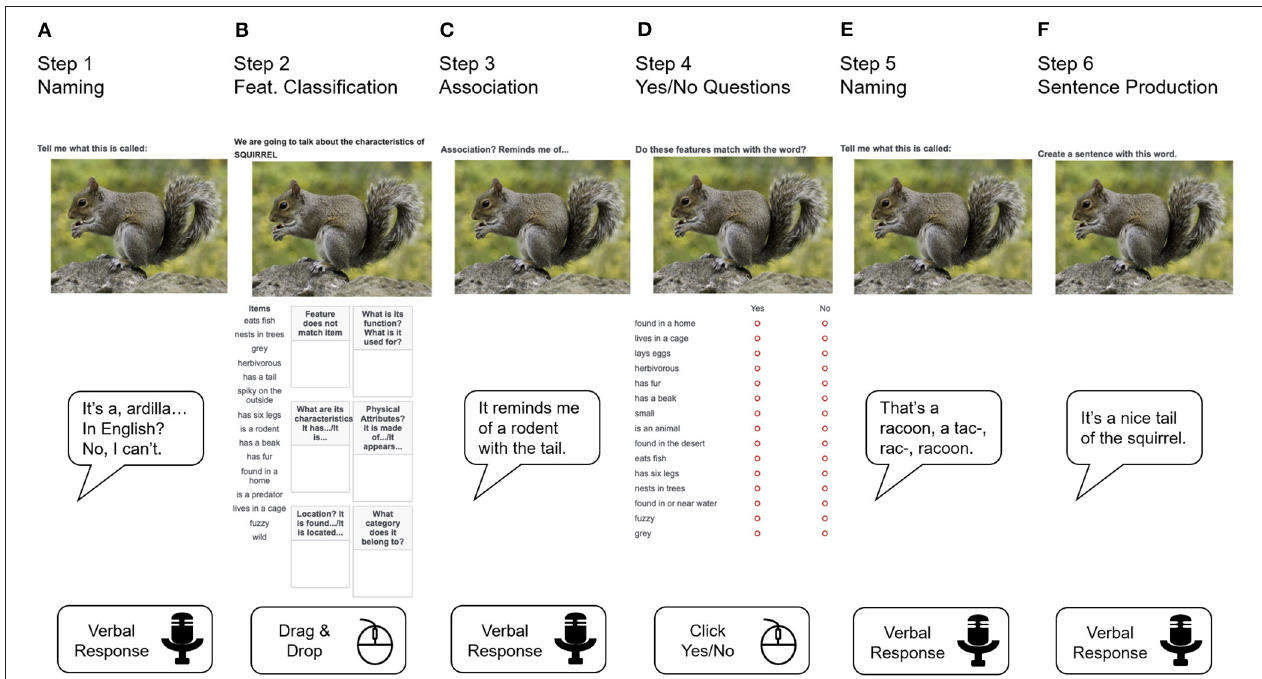
FIGURE 1 | Treatment steps. Example of treatment steps presented across six consecutive screen displays for the treatment item “squirrel.” In step 1, the patient provides a verbal naming response for the picture (A) . In step 2, the patient drags and drops the semantic features that do not apply to the pictured item into the “feature does not match item” box with the mouse (step 2A) and assigns the remaining features to the other boxes (step 2B) (B) . In step 3, the patient provides an association for the item (C) . In step 4, the patient decides whether each semantic feature matches the item by clicking on the yes/no options with the mouse (D) . In step 5, the patient completes a second naming trial for the picture (E) . In step 6, the patient generates a sentence using the treatment word (F)